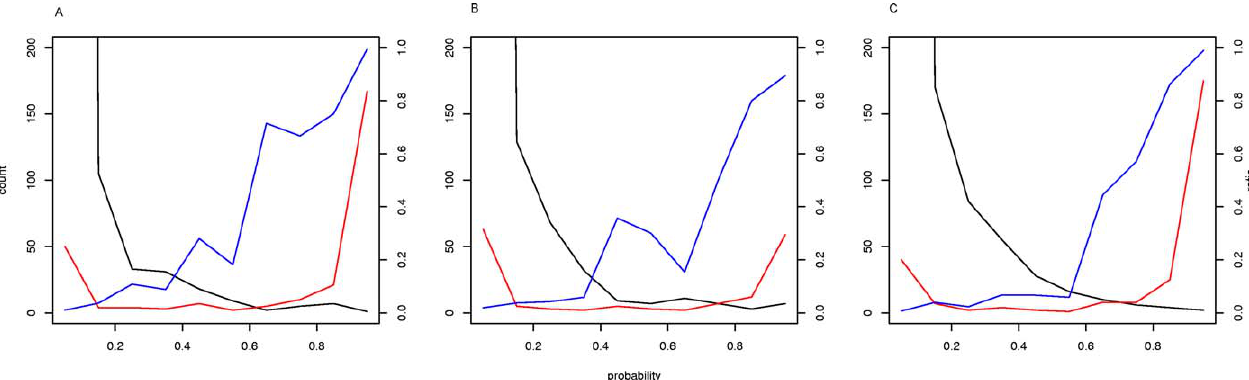
Figure 3. Performance of the GO Integration on Benchmark Set (A) Alpha-helical proteins, (B) beta-sheet proteins, and (C) alpha-helical/beta-sheet proteins. The x -axis is P (SF j D,GO); the y -axis the number of matches with that score that are incorrect (black) and correct (red). The blue line is the ratio